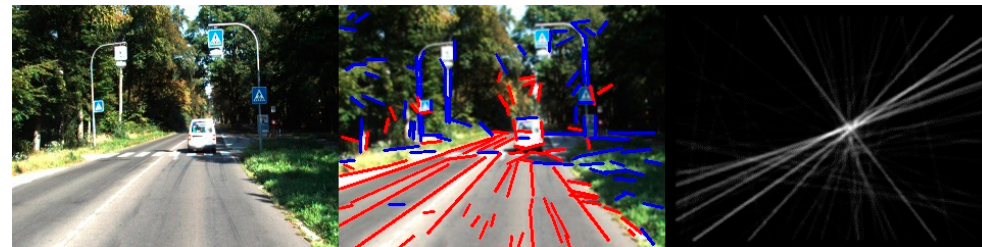
Figure 5. The first column is the input image. The second column is the detected line segments by LSD (the red line segments are valid and the blue line segments are invalid). The third column is the line space voting image.